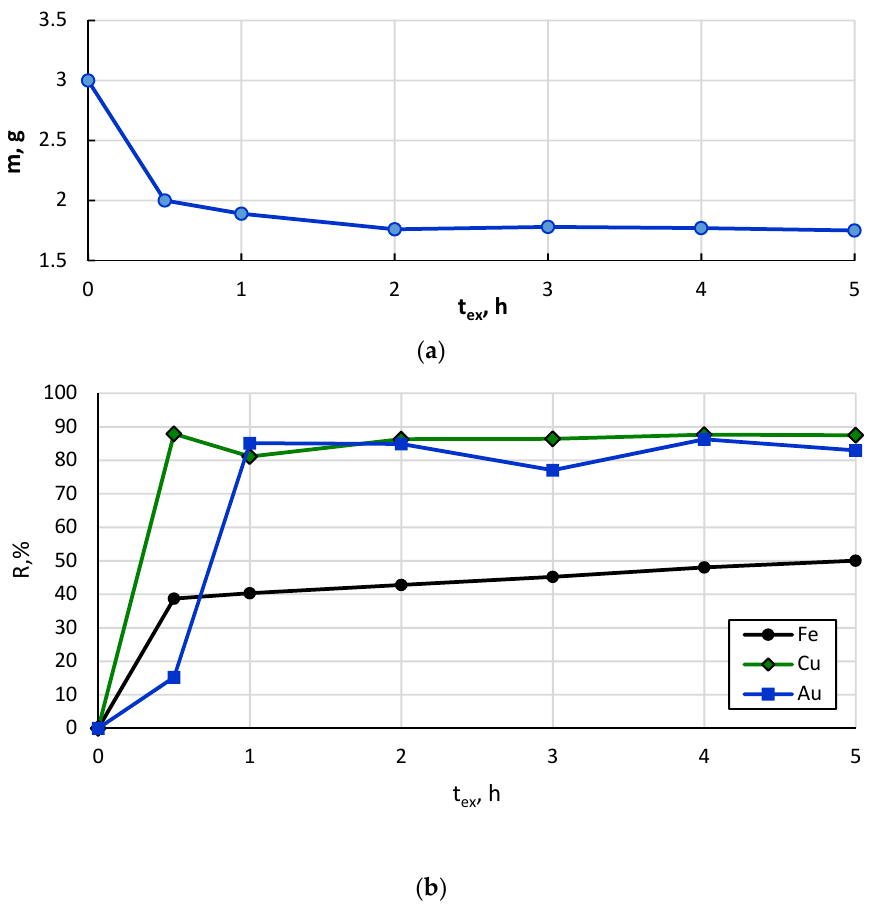
Figure 13. Impact of the experiment duration on the weight of solid residue ( a ) and the degree of gold, copper, and iron leaching ( b ). Experimental conditions: raw material fraction [A], C HCl = 6 M, i = 0.88 A·cm –2 , and S/L = 8.6 g·L –1 . Solid residues from the experiments at different durations: 0.5 h, 2 h, 4 h and 5 h (Figure 13a) were studied using the XRD method (Figure 14).